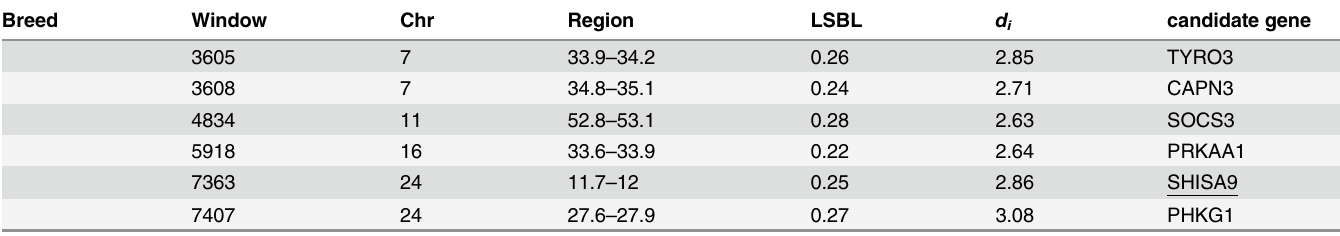
Table 4. The genes in overlapping selection windows. Chr window SNP